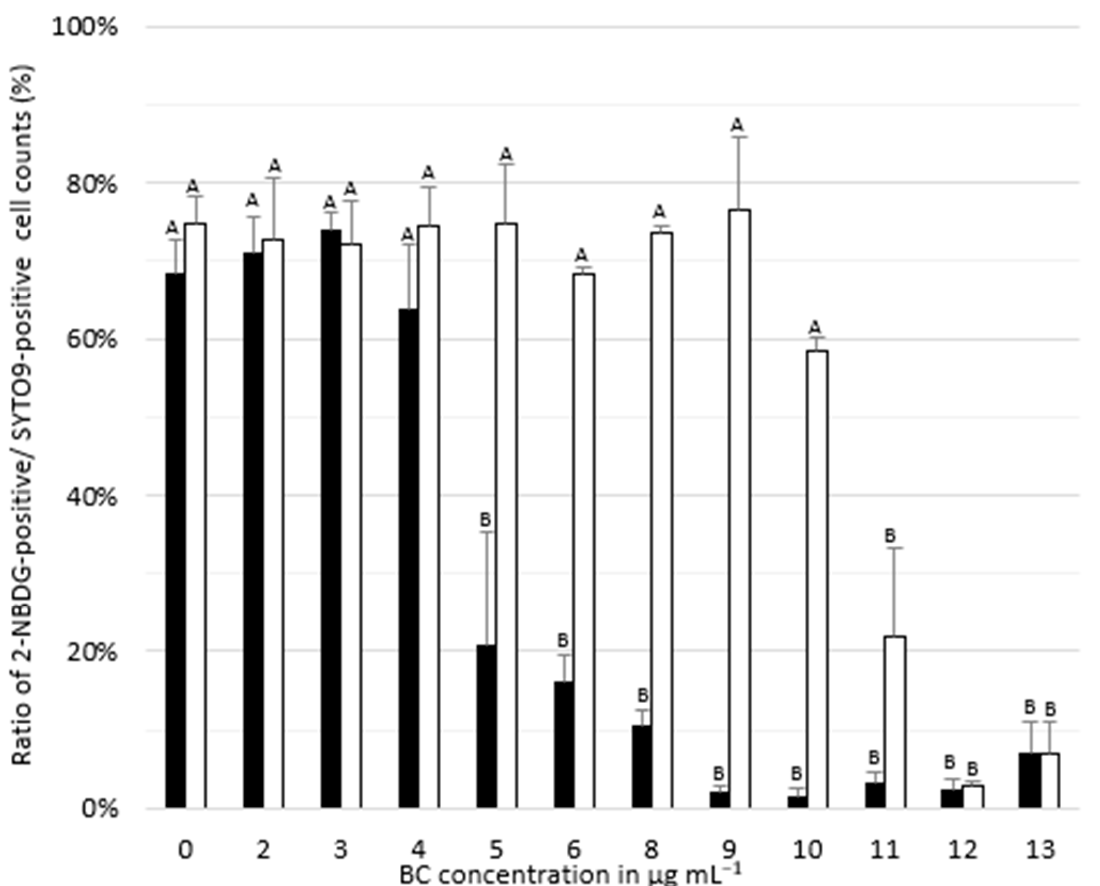
Figure 3. Mean ratio of 2-NBDG-positive to SYTO9-positive parent (black bars) and adapted Listeria monocytogenes SLCC2540 cells (white bars) following cultivation in brain heart infusion broth containing benzalkonium chloride (BC) in various concentrations. 2-NBDG-positive cells are indicative of metabolically active cells, while SYTO9-positive cells represent the total number of cells. Error bars show the standard deviation of three replicates. Different letters above bars within panels indicate significant differences ( p < 0.05) according to two-way analysis of variance (ANOVA).